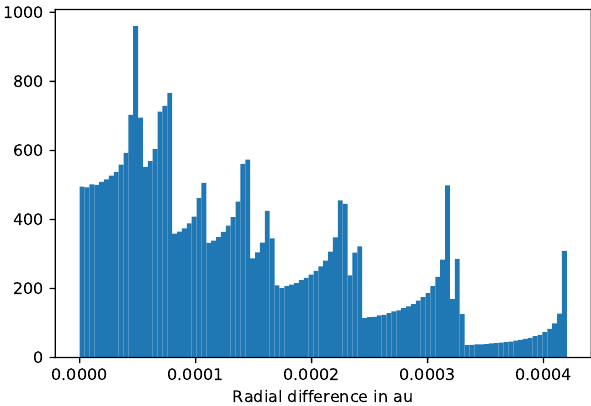
Fig. 108.— Histogram of the square difference between fitted ellipse and simulated ellipse